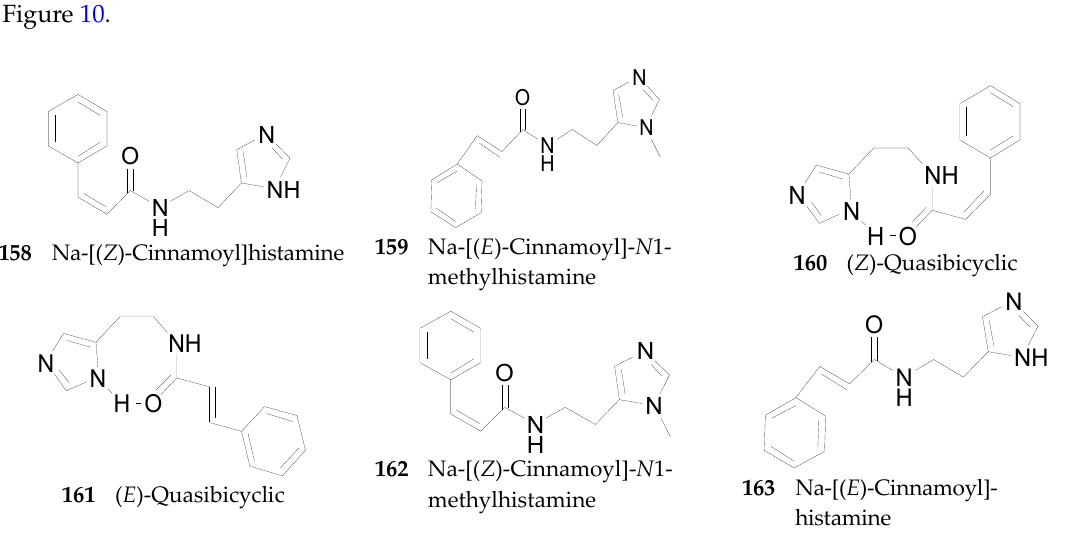
Figure 9. Chemical structures of compounds 144 – 157 .